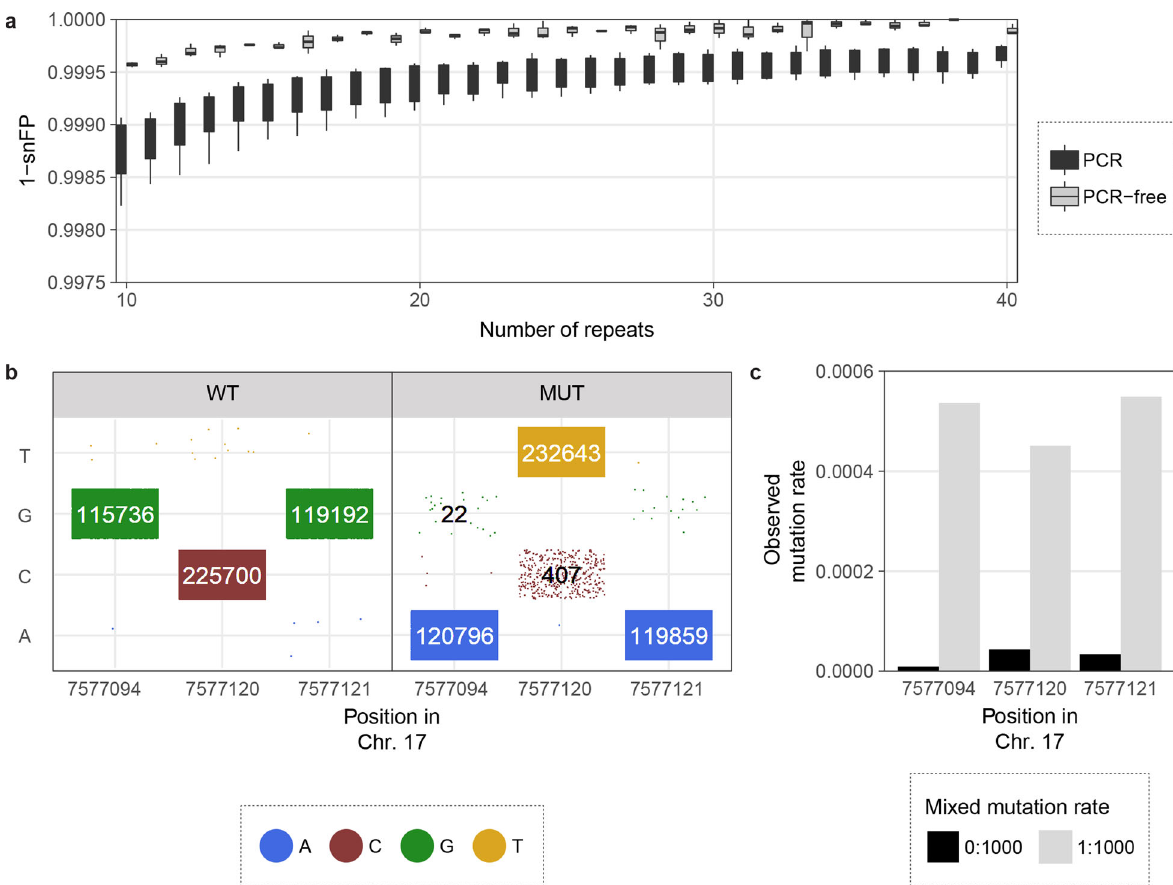
Fig. 5 Detecting mutations in a synthetic TP53 exon using CyclomicsSeq. a Box plots (center line = median; box limits = 25th and 75th percentiles; whiskers = 1.5× interquartile range; data points = outliers) depicting 1 - single-nucleotide false positive (snFP) rate in the insert (17:7577010 – 7577150 in GRCh37) per number of repeats for 8 PCR and 3 PCR-free inserts. b Calls in WT and MUT at the three mutant positions in TP53 . Data points represent single reads. Colors indicate base call in the consensus-called read. Numbers >20 reads are shown, of which true negatives and true positives are indicated in white. c Observed mutation rate in WT and mixed WT/MUT at the three mutant positions in TP53 . Expected mutation rates are 0.000 in WT and 0.001 in mixed